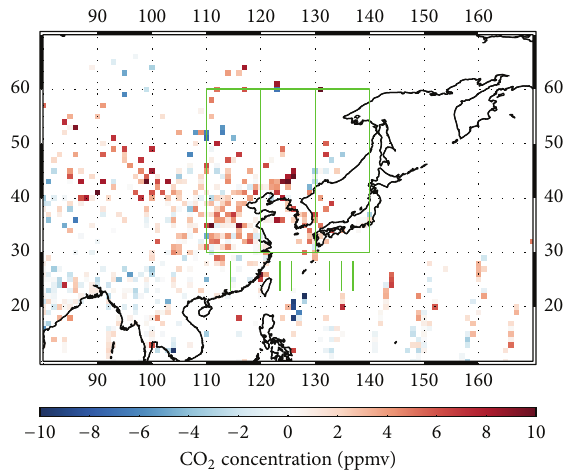
Figure 6: Difference in CO 2 concentration between HC and all periods of the East Asian region using GOSAT SWIR. Region I (30–60 ∘ N, 110–120 ∘ E) covers the eastern region of China, and Region II (30–60 ∘ N, 120–130 ∘ E) covers the Yellow Sea and the Korean Peninsula, while Region III (30–60 ∘ N, 130–140 ∘ E) represents Japan.